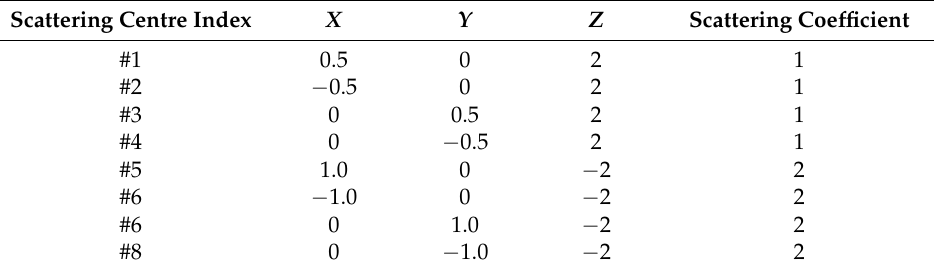
Table 1. Parameters of the scattering centers.